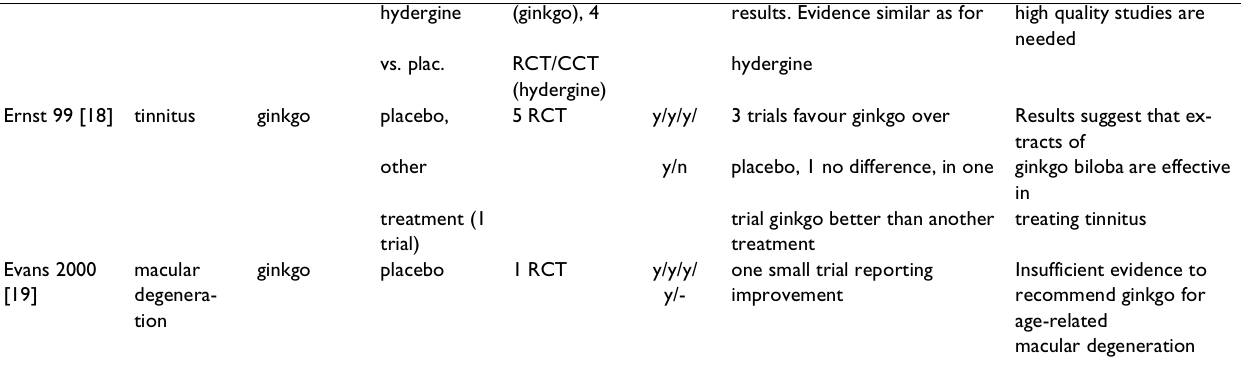
Table 1: Systematic reviews of clinical trials of ginkgo biloba extracts (Continued)